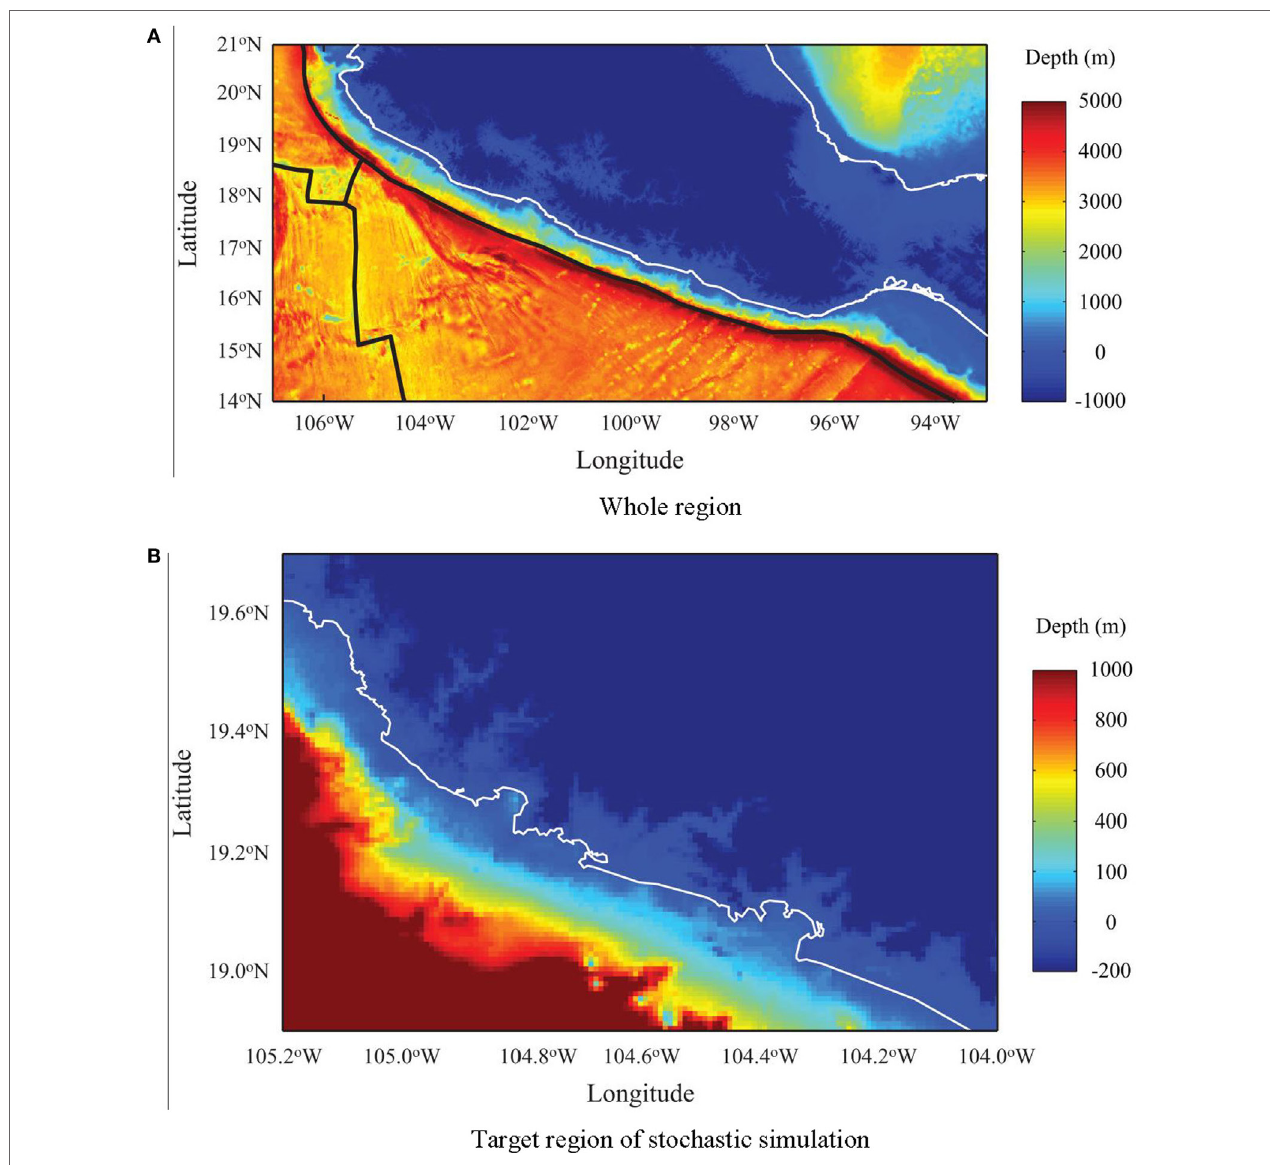
FigUre 4 | Bathymetry data for the Guerrero region (GEBCO2014, unit: meters). (a) Whole region. (B) Target region of stochastic